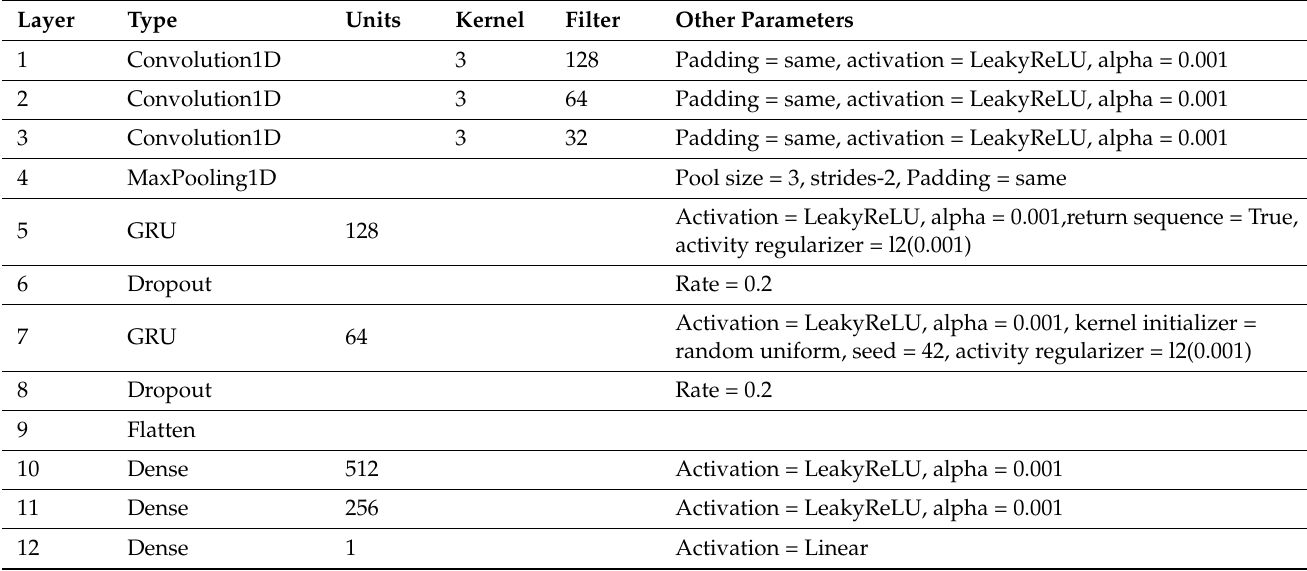
Table 2. Proposed Model (1D-CNN-GRU)